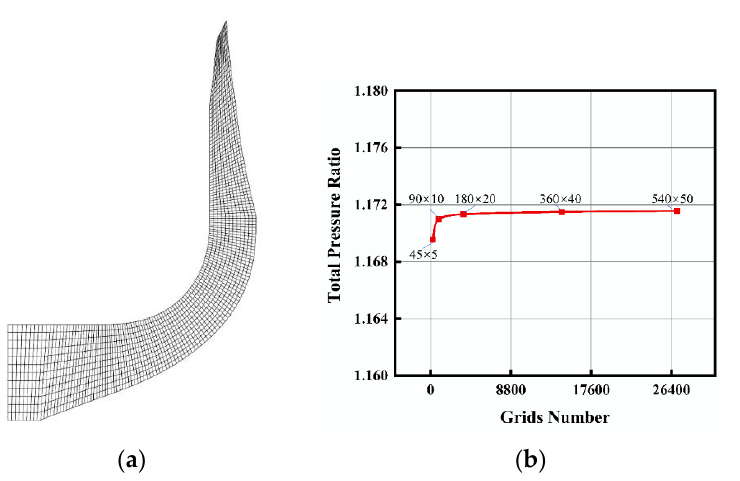
Figure 2. Computational grid of the LSCC. ( a ) Coarser grid; ( b ) grid-independence validation.